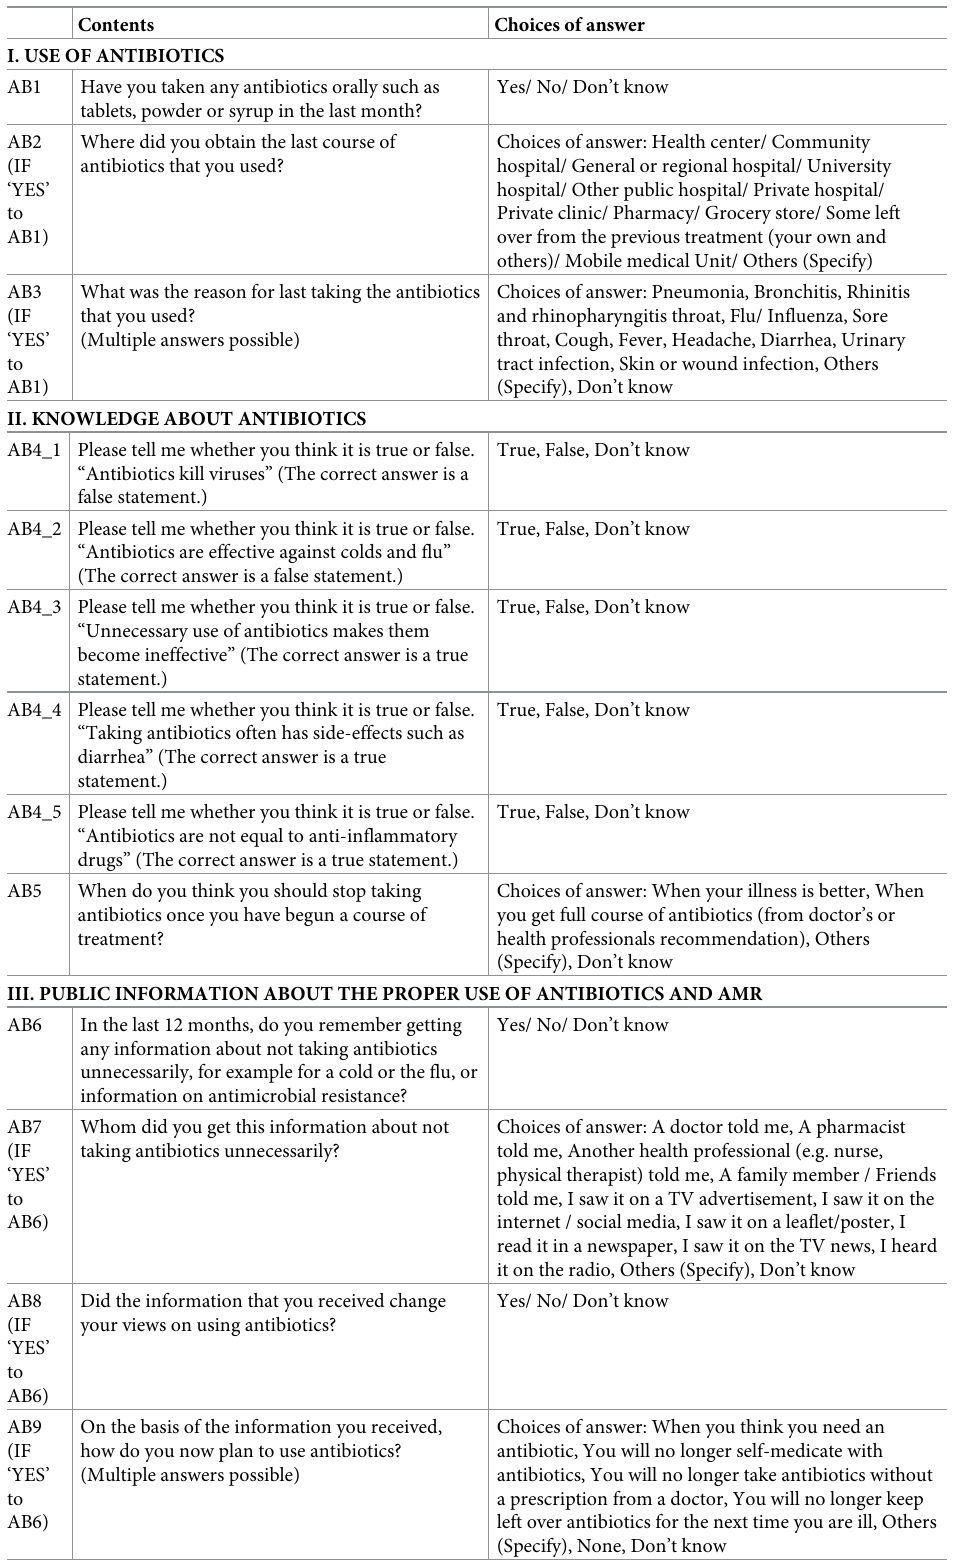
Table 1. AMR module embedded in 2017